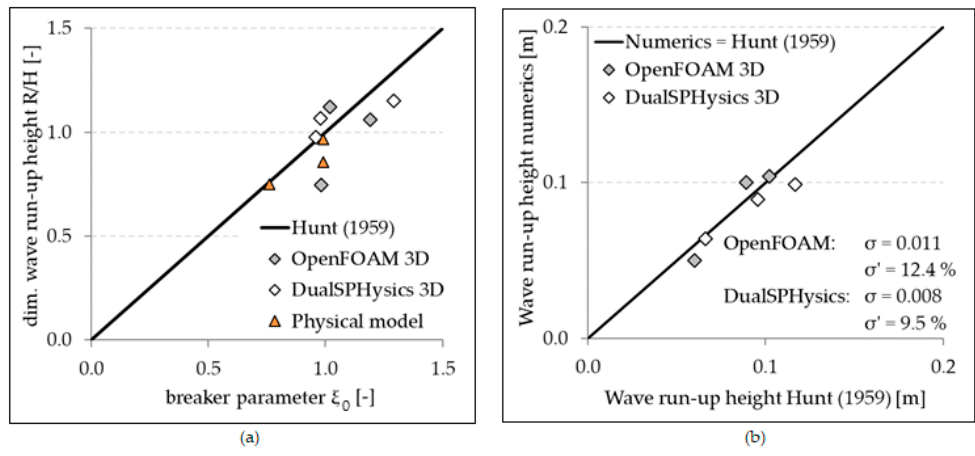
Figure 4. ( a ) Wave run-up on a 3D straight dike with perpendicular wave attack ( b ) Results of the wave run-up calibration on a 3D straight dike compared to Hunt (1959).